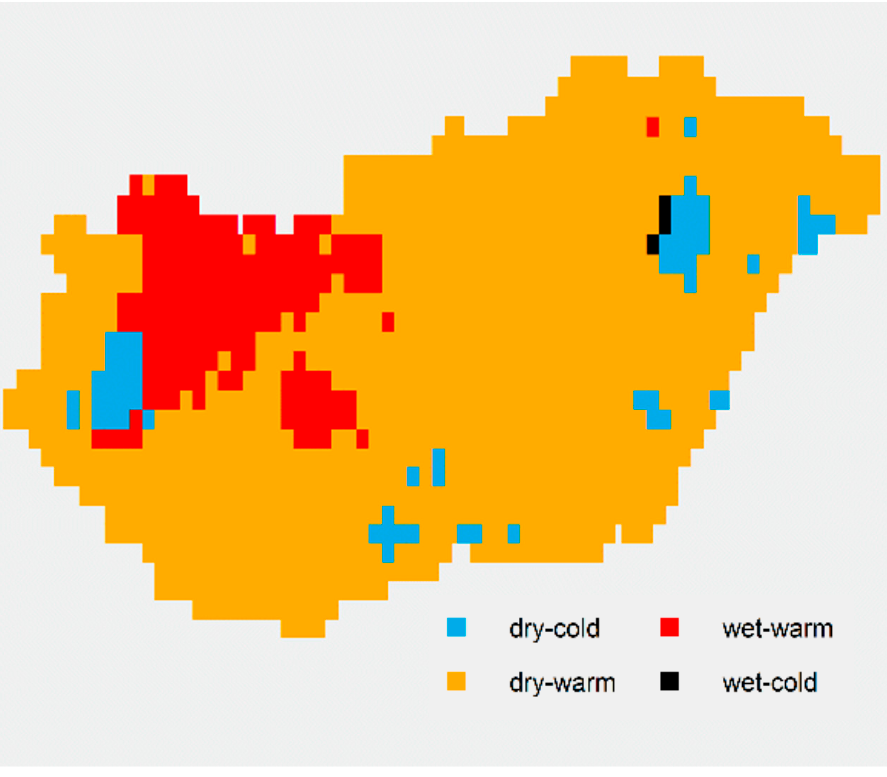
Figure A4. Characteristics of extreme months (March).